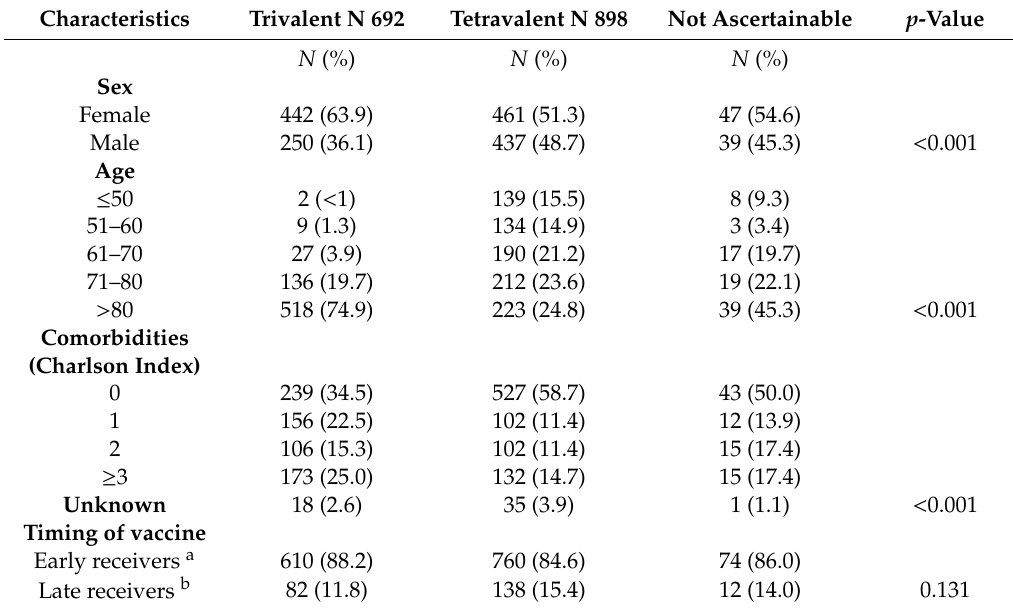
COVID-19 patients who received influenza immunisation, according to type of vaccine